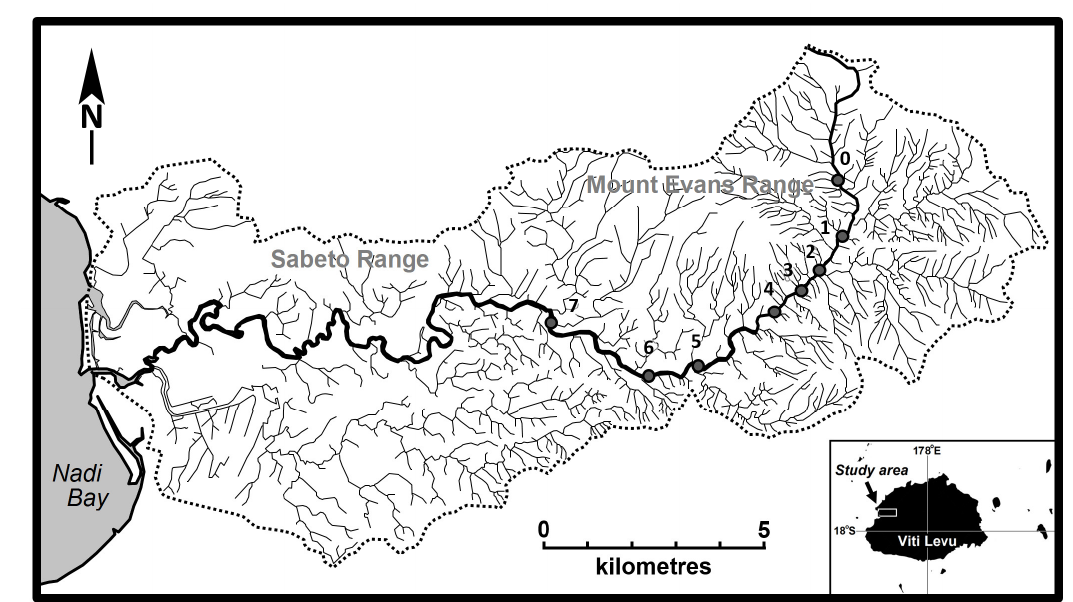
Figure 1. The drainage and catchment of the Sabeto River of western Viti Levu, Fiji, showing the location of the sampling sites. Modified from Gale et al. [32].